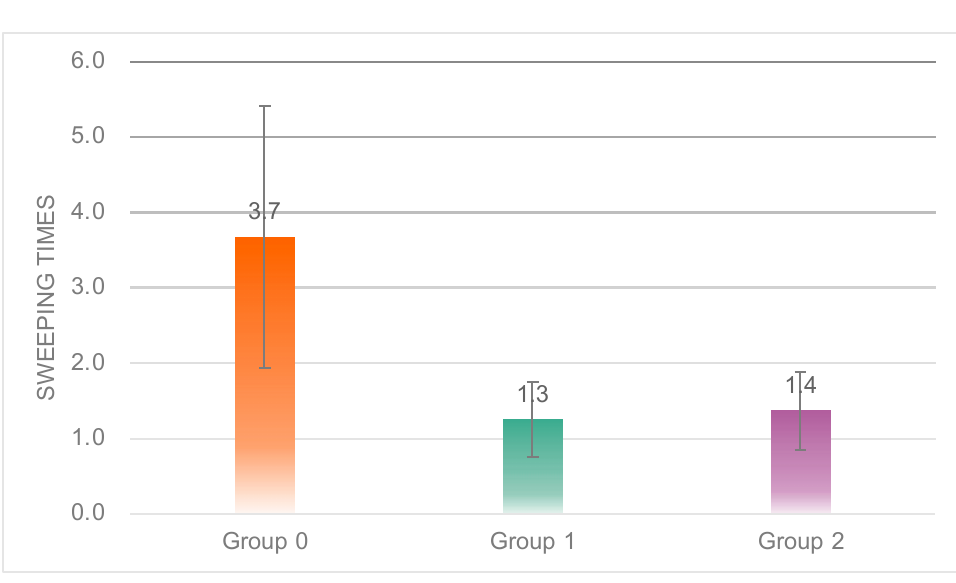
Figure 12. Individual differences in the total sweep times of the three groups.